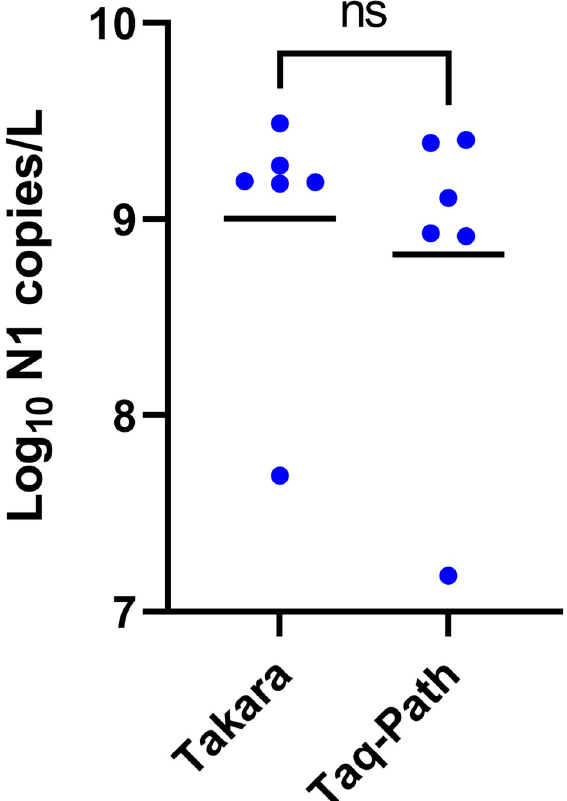
Fig 7. Effect of different RT-qPCR enzymes: Copy number yield for the N1 target for 24-hr composite wastewater samples obtained from 6 wastewater treatment plants (WWTP). RT-qPCR assays performed with the TaqPath 1-Step RT-qPCR enzyme recommended by the CDC [20] are compared to RT-qPCR assays performed with One Step PrimeScript III enzyme. Each point in the mean of 2 technical replicate measurements from a 24-hour composite sample. Horizontal black lines show means. See Fig 2 legend for explanation of pairwise